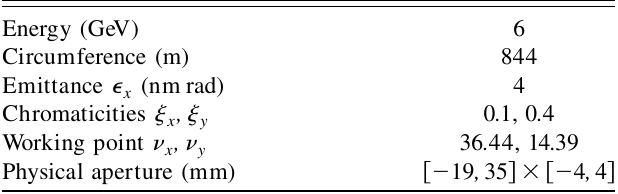
TABLE II. ESRF main parameters.